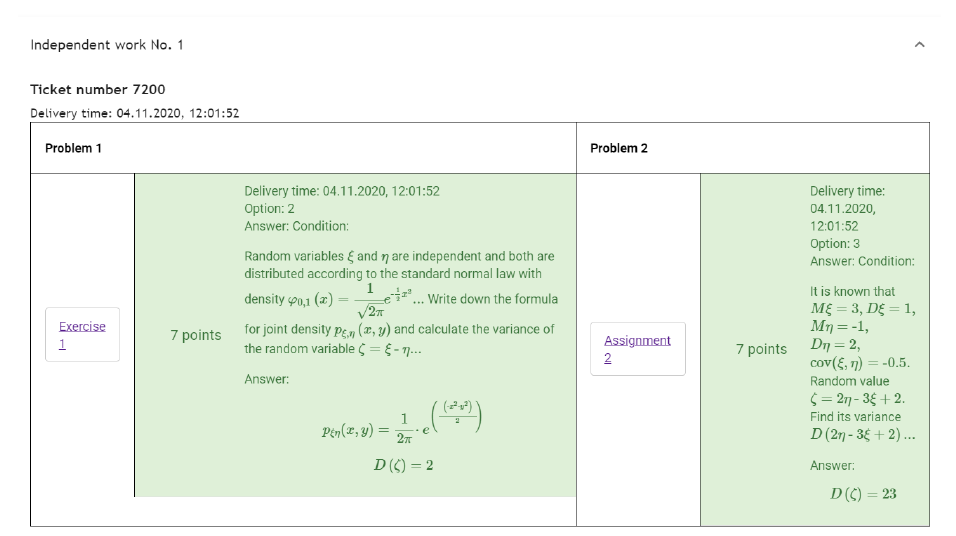
Fig. 5. Representation of the student's task-completion result in the Personal-account window in the DLS Nomotex.